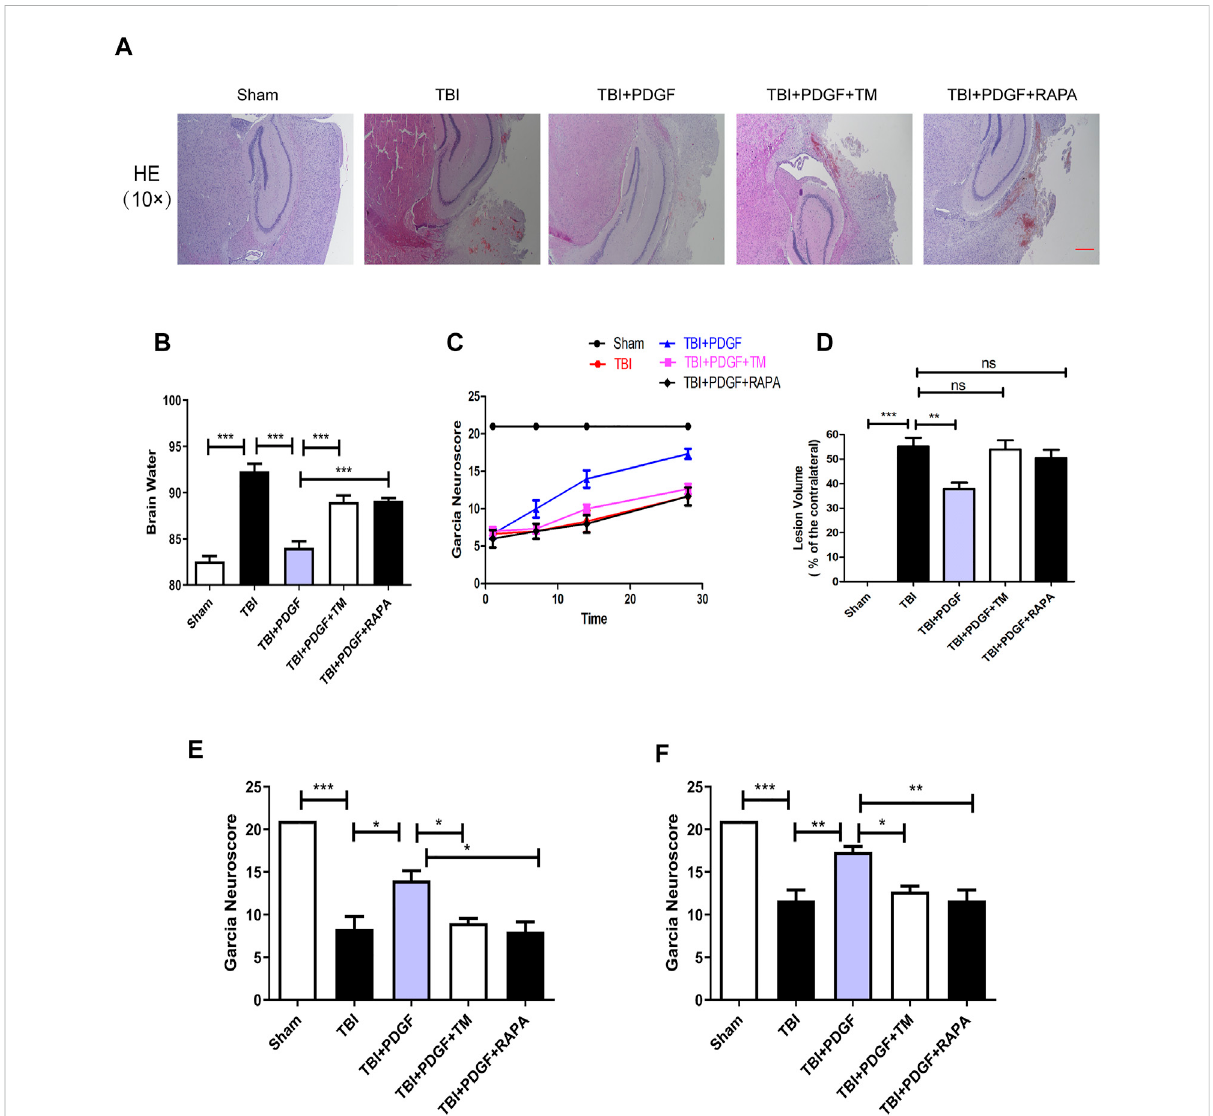
FIGURE 6 ThePDGFtreatmentimprovesthefunctionalrecoverythroughERstressandautophagyafterTBI. (A) Representativeimagesofhematoxylinand eosin (H&E) staininginthecortexat21dpost-TBI.Scarbar=100 μ m. (B) Quanti fi cationofbrainwatercontentintheipsilateralbraincortexat3dafter TBI. (C) Garcia test evaluation at 1 day, 7 days, 14 days, and 28 days after TBI. (D) Quanti fi cation of lesion volume after H&E staining at 21 days post- TBI; (E) Garcia test evaluation at 14 days after TBI. (F) Garcia test evaluation at 28 days after TBI. Data represent the mean ± SD, n = 3, * p < 0.05, ** p < 0.01 and *** p < 0.001 vs. the indicated